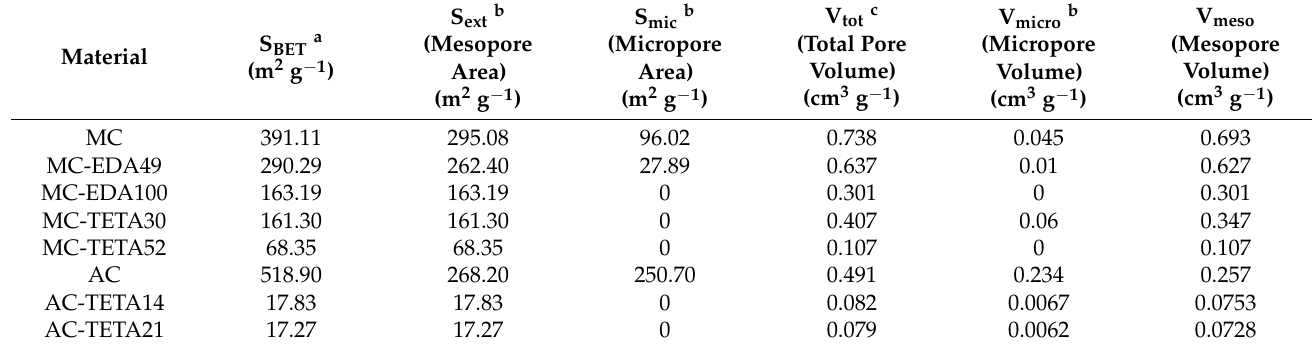
Textural parameters of mesoporous carbon and commercial activated carbon before and after amine- functionalization. S BET , specific surface area, calculated using the Brunaeur–Emmett–Teller (BET) method.